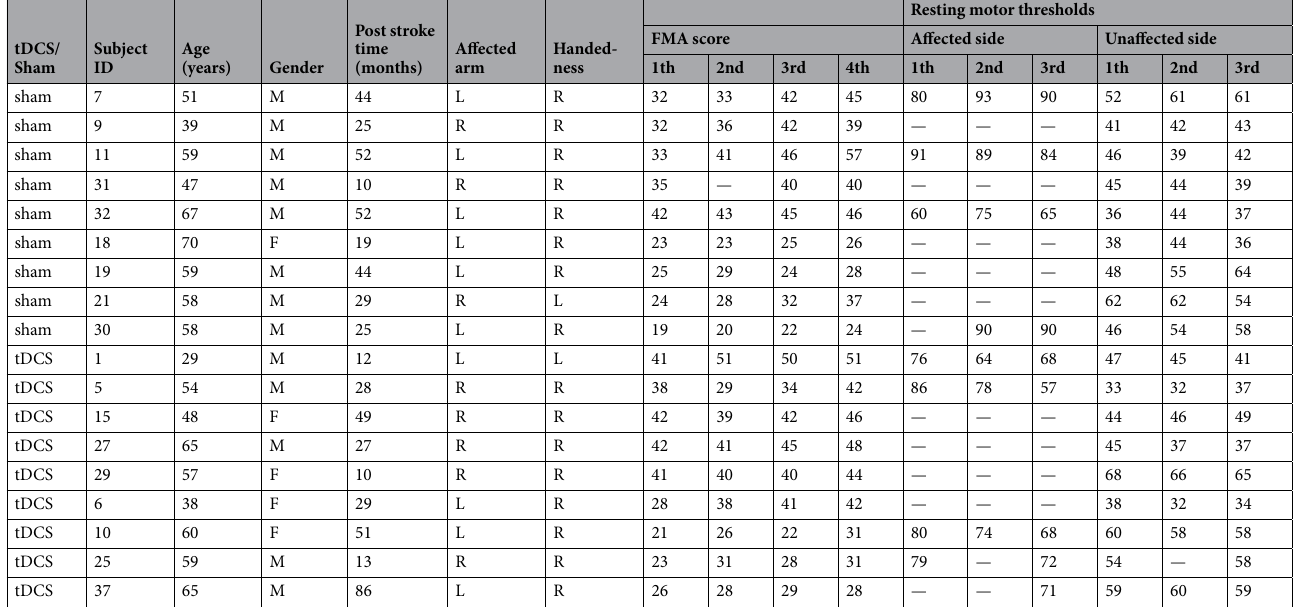
Table 1. Demographic and clinical data. Note: * Subject #31 was not available for the 2 nd FMA